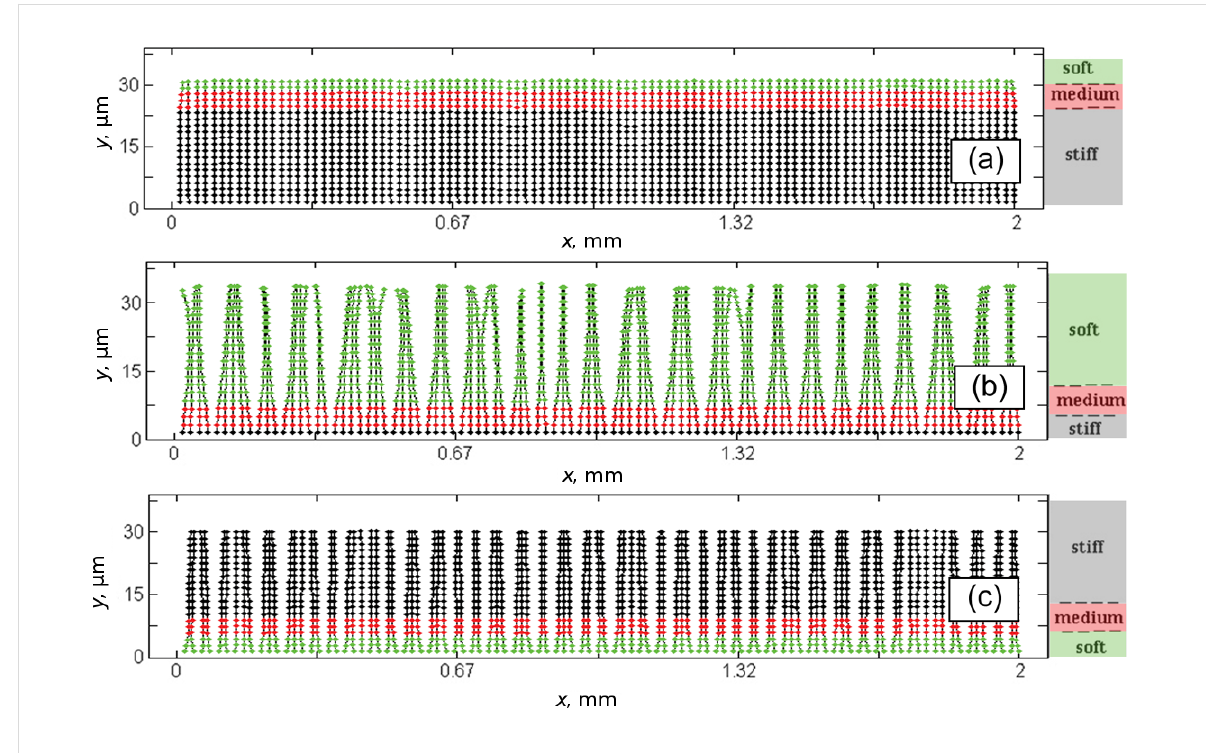
Figure 3: The same system as presented in Figure 2 shown after detachment from the fractal surface and sufficiently long relaxation to the static state. The difference between strongly clustered systems having either long elastic (b) or long stiff filaments (c) and the system with short soft ends (a), which practically returns back to its original configuration, is clearly seen. See also complementary movies 1, 2, 3 (Supporting Information File 1), which correspond to the cases (a), (b), (c),